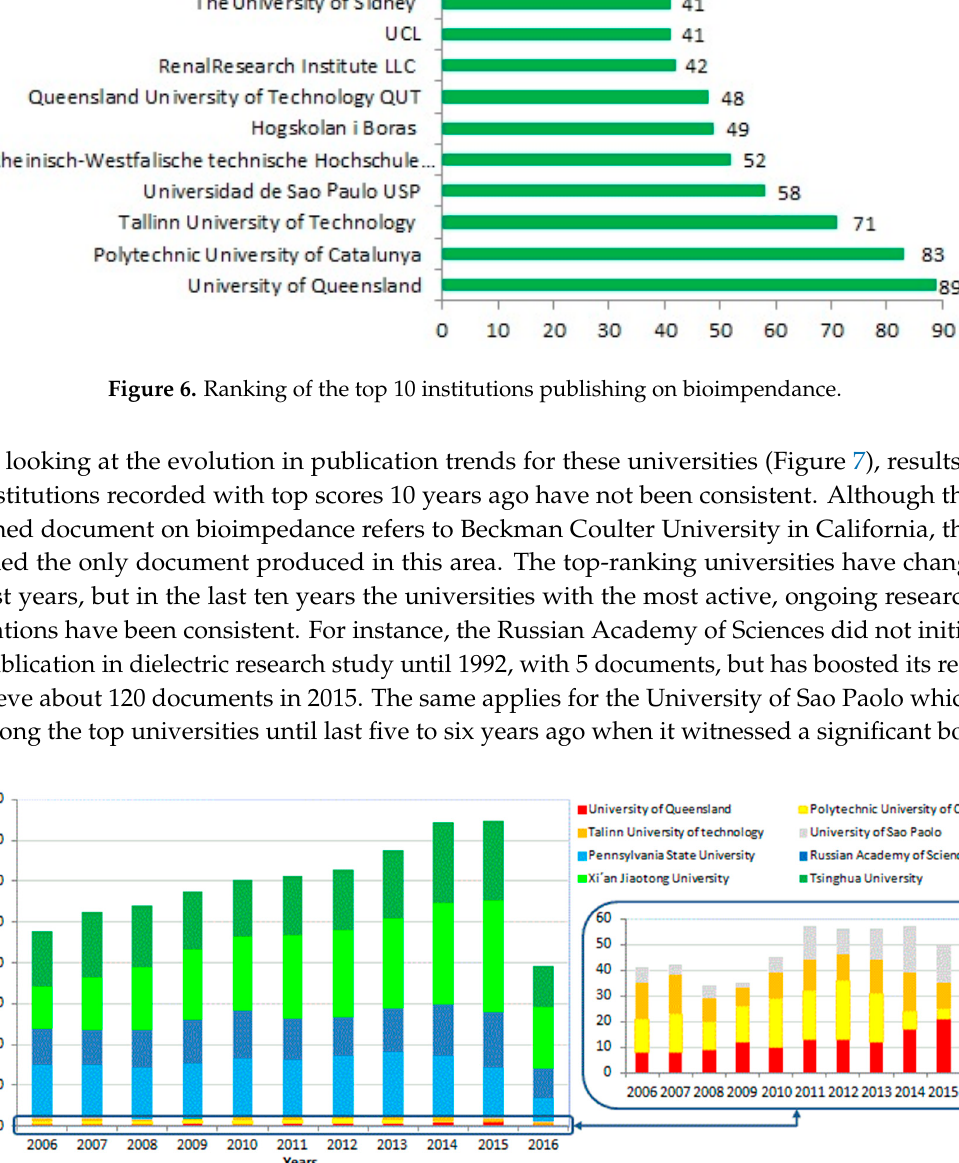
Figure 7. Time evolution for the recent 10 year period for the 10 most prolific institutions.